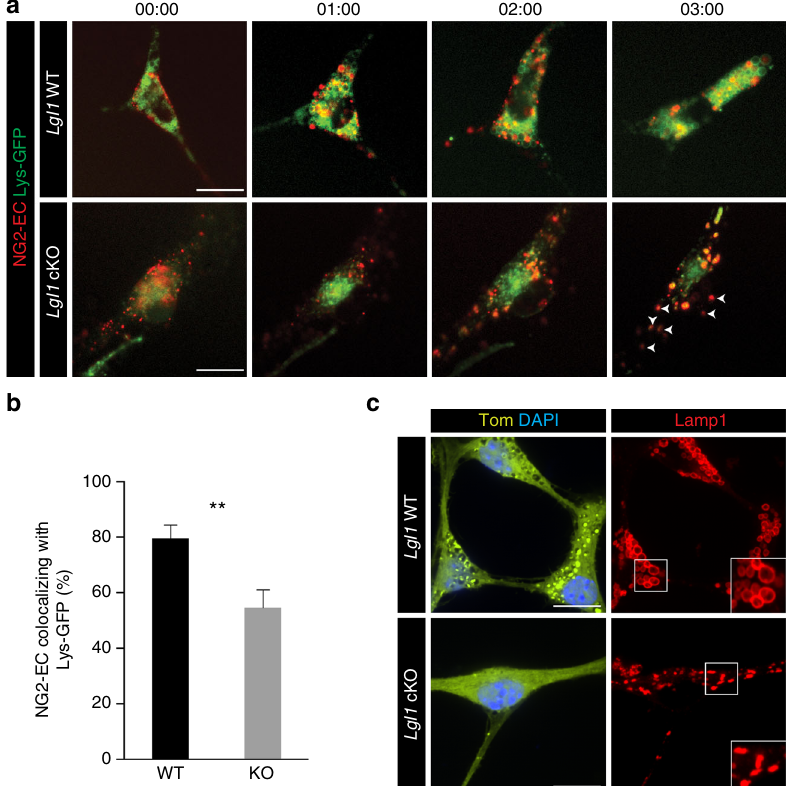
Fig. 5 Lgl1 cKO OPC show defect in NG2 routing to the lysosome. a Time-lapse fl uorescent pictures of Lgl1 WT and Lgl1 cKO OPC labeled for NG2-EC (red) and lysosome (Lys-GFP, green) under differentiation conditions. Pictures are acquired every hour for 3 hours. White arrows indicate NG2-EC that did not reach the lysosome. Time indicated as hours:minutes. Scale bar: 25 μ m. b Quantitative graph representing the ratio of labeled NG2 puncta in the lysosomes in WT (black) and Lgl1 cKO cells (gray). Data are represented as mean ± s.e.m., n = 10 cells each genotype, three independent experiments (** p < 0.01, Student ’ s t -test). c Immunostaining of NG2dTom cells (yellow) with lysosomal protein Lamp1 (red) showing the difference in lysosome shape between Lgl1 WT OPC and cKO OPC. Scale bar: 25 μ